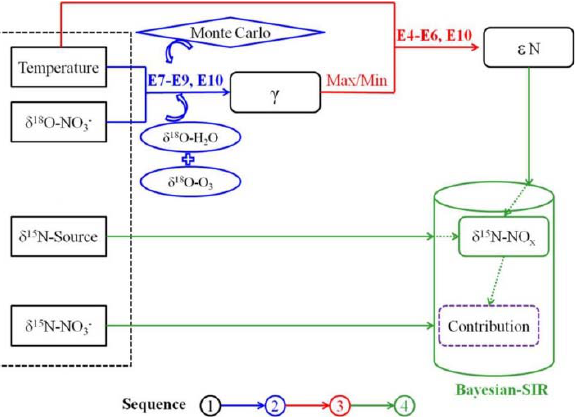
Figure 5. Principle and process of the improved Bayesian model by Zong et al.; the “E” represents equation in the following section, “ ε N” refers to N fractionation, and “SIR” is “sampling-importance-resampling”. Reprinted with permission from Ref. [57]. Copyright 2017 ACS.